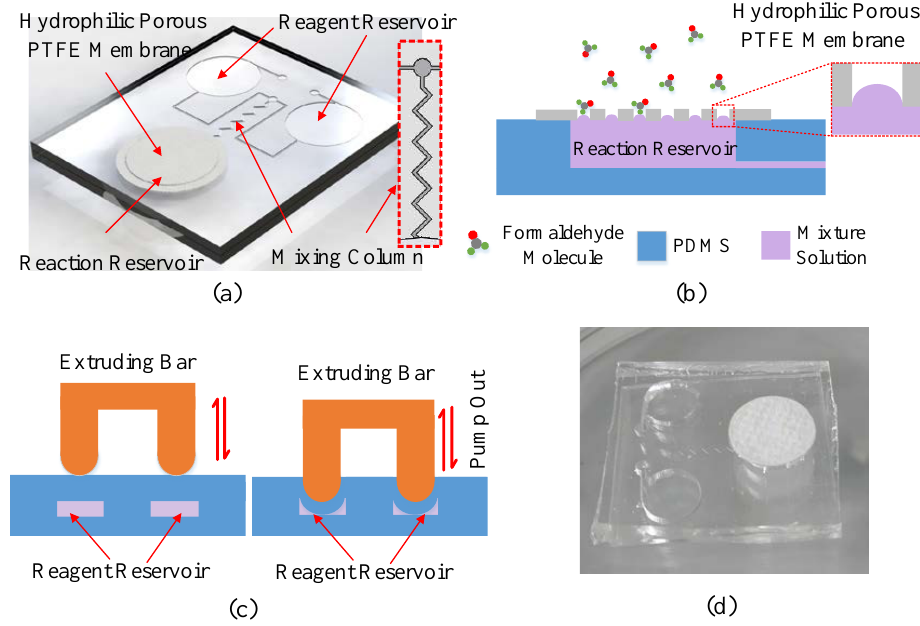
Figure 1. ( a ) Three-dimensional diagram of a microfluidic chip, ( b ) the working principle of the reaction reservoir, ( c ) the working principles of the reagent reservoirs and mixing, ( d ) the image of the microfluidic